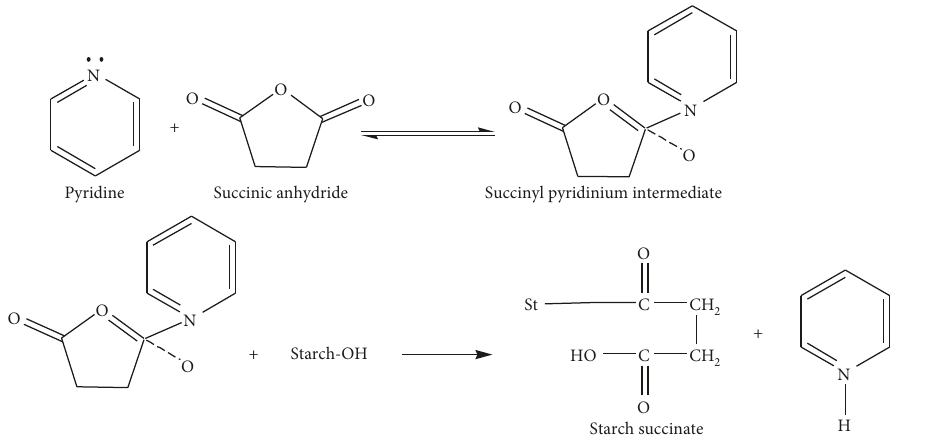
Scheme 5: Starch modification with succinate and pyridine.